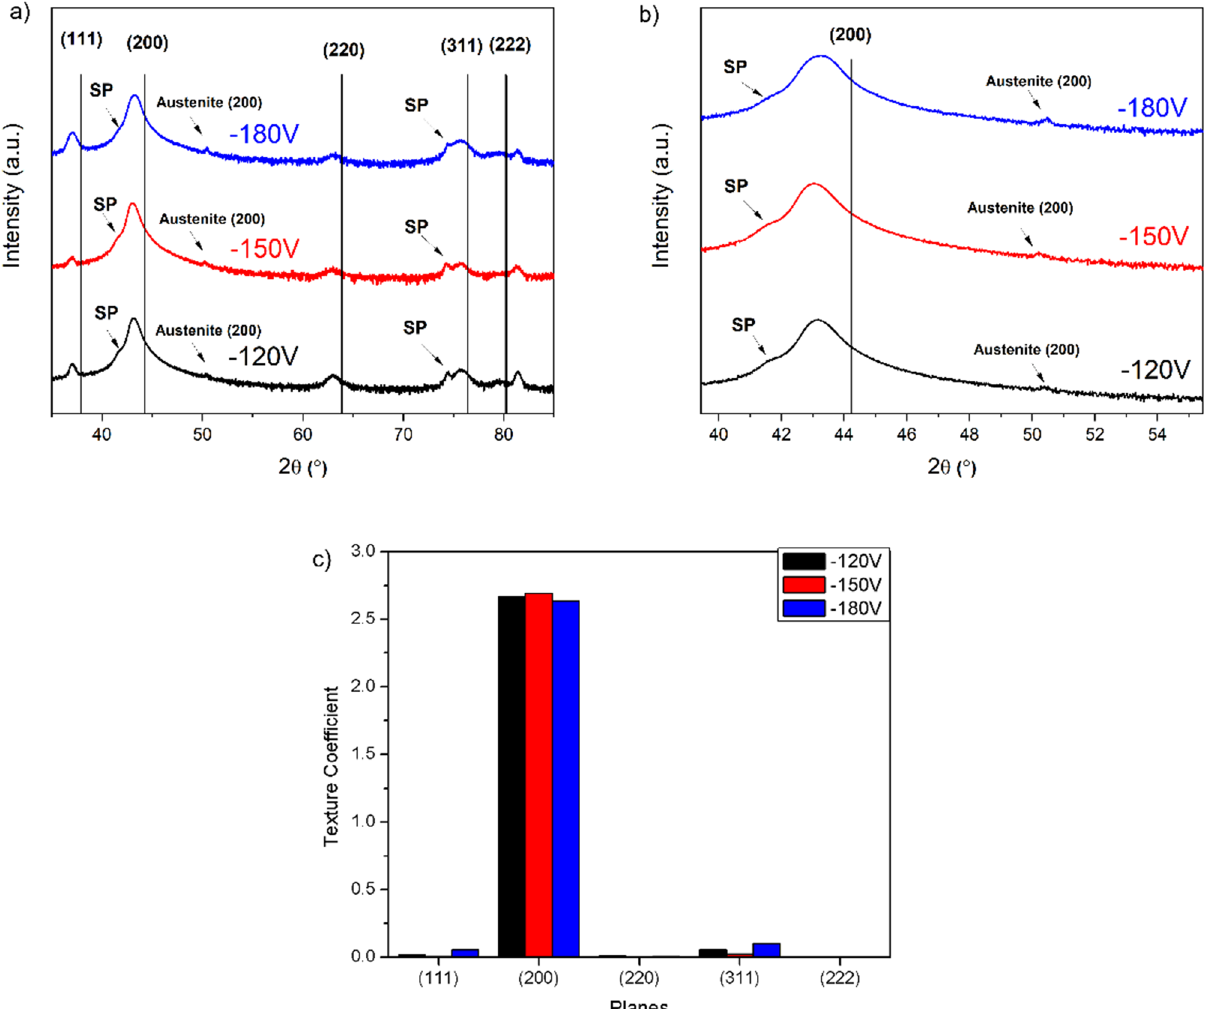
Figure 2. X-ray diffractograms ( a ), detail around the CrN (200) peak position showing the satellite peaks ( b ) and texture coefficients ( c ) for the CrN/Cr 1-x Al x N multilayers produced at constant carousel speed (1 rpm), using different bias levels (− 120 V, − 150 V or − 180 V). The satellite peaks (SP) indicate the formation of a superlattice. Austenite peaks from the substrate are also